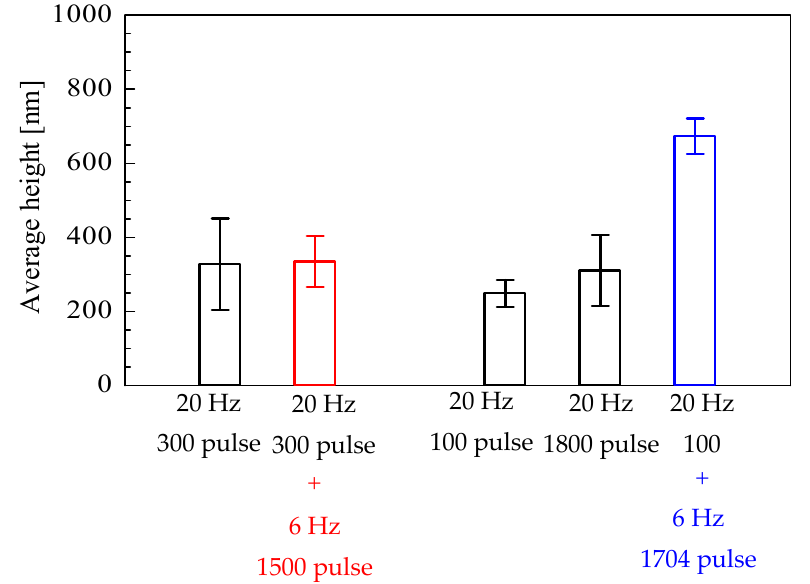
Figure 5. Increase in average heights of the photochemical micro-/nano-swelling formed on silicone rubber when a second ArF excimer laser at a pulse-repetition rate of 6 Hz irradiated the micro-/nano-swellings before and after the saturation.